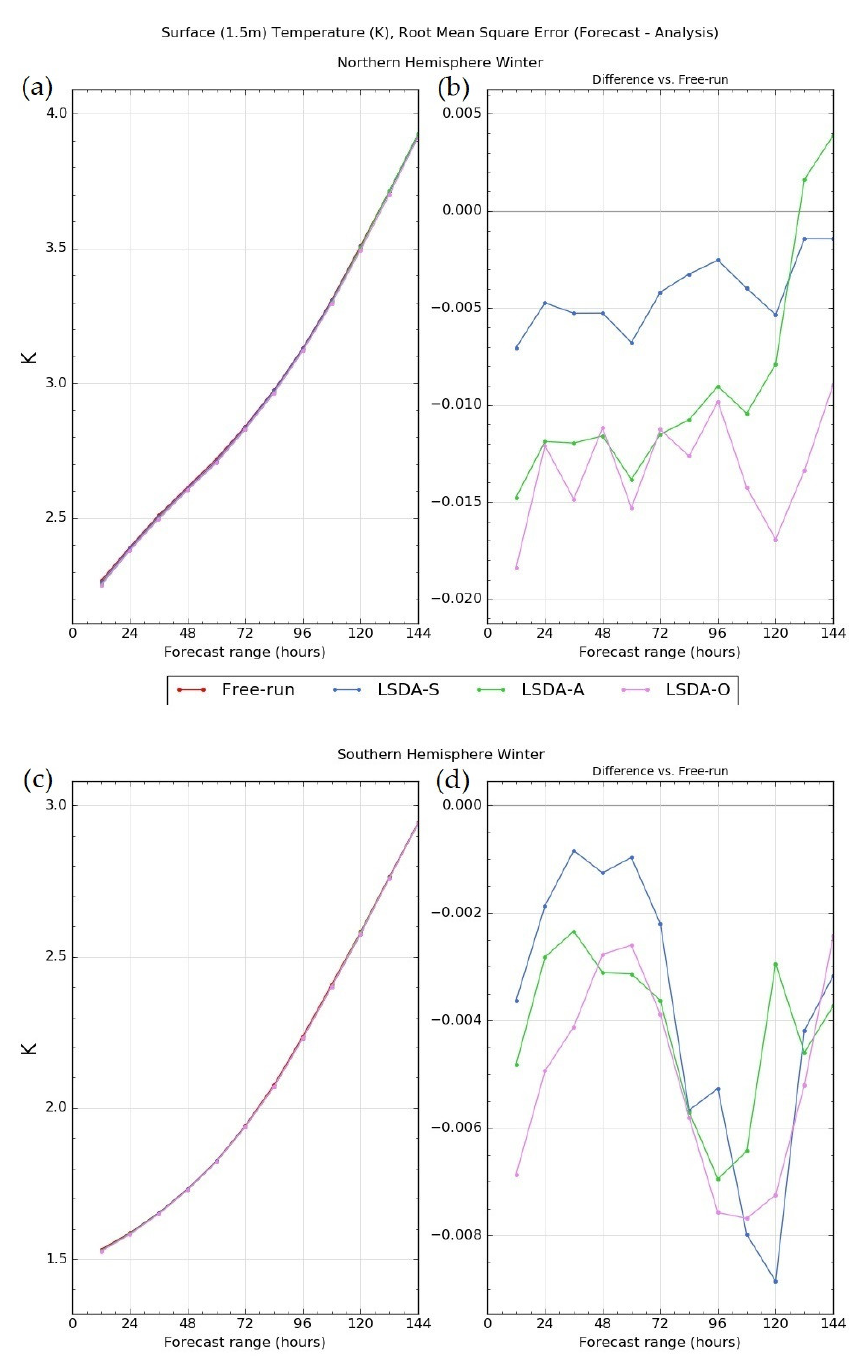
Figure 4. Winter F- EC analysis. Root mean squared errors or RMSE (panels a , c ) in surface (1.5 m) temperatures (Kelvin) computed for global forecasts against the European Centre for Medium-Range Weather Forecasts (ECMWF) global analyses [43] for all forecast ranges up to T + 144 h. Shown are the control run without LSDA or open-loop (red) and the experiments: assimilation of pseudo-observations of screen-level temperature and humidity only (blue), assimilation of ASCAT only (green) and assimilation of both observation types (pink). Panels ( b , d ) show the RMSE difference between the control and the three experiments such that a negative result means improvement of the experiment over the control. Panels a and b are for the Northern hemisphere winter period, 1 December 2017 to 19 February 2018 (81 days). Panels c and d are for the Southern hemisphere, 15 July 2018 to 15 October 2018 (92 days).